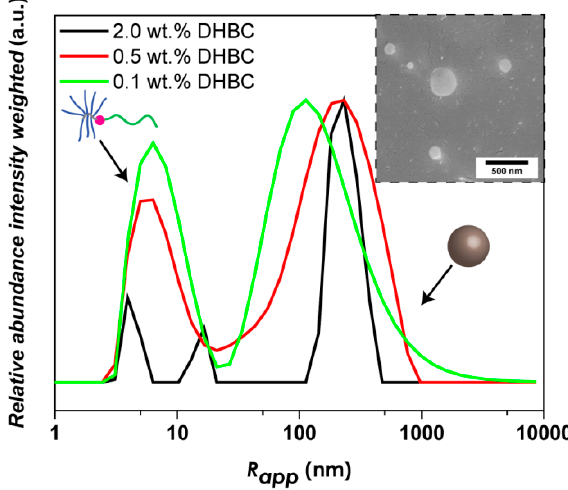
Figure 1. Intensity-weighted size distribution of PVP- b -P(OEGMA) in Millipore water measured via dynamic light scattering (DLS) at 25 °C and at concentrations between 0.1–2.0 wt.%. Inset: Cryogenic scanning electron microscopy (cryo-SEM) imaging of PVP- b -P(OEGMA) DHBC at a concentration of 2.0 wt.%, indicating existence of larger structures.